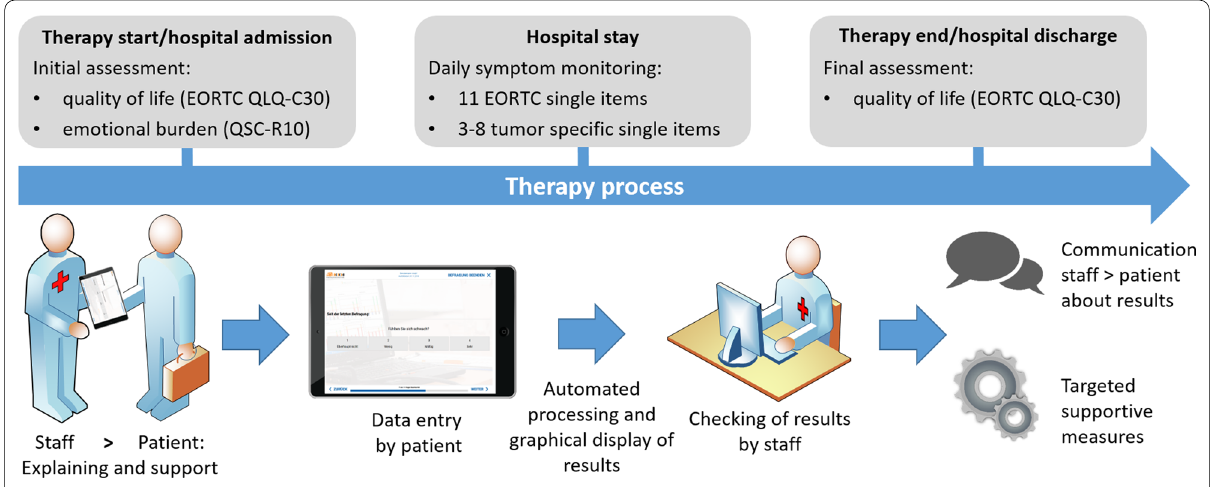
Fig. 1 Overview of the assessment instruments and clinical